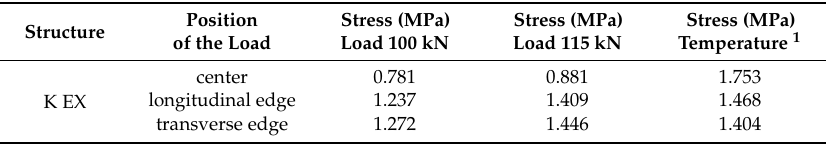
Table 2. Calculated stress in concrete slab structure K EX.